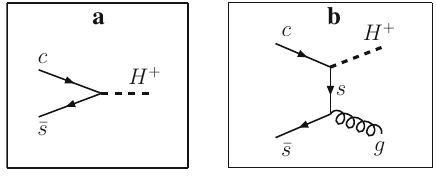
Fig. 10 Feynman diagrams for the production processes (6.5)